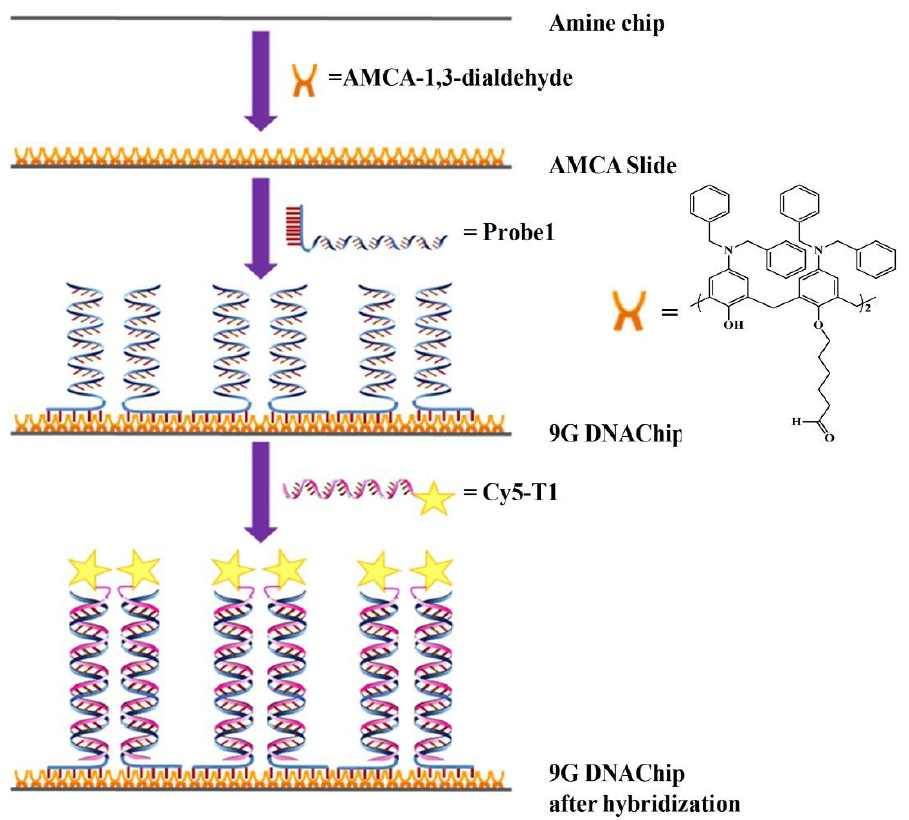
Figure 6. Preparation of 9G DNAChip and hybridization thereafter